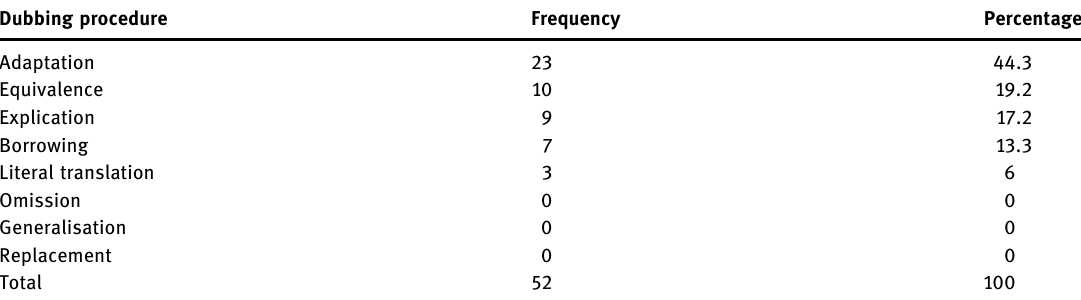
Table 1: Frequencies and percentages of dubbing procedures used in EVA in